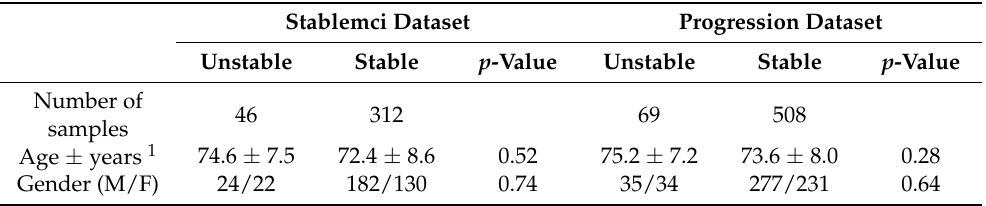
Table 1. Characteristics information of datasets for biomarker